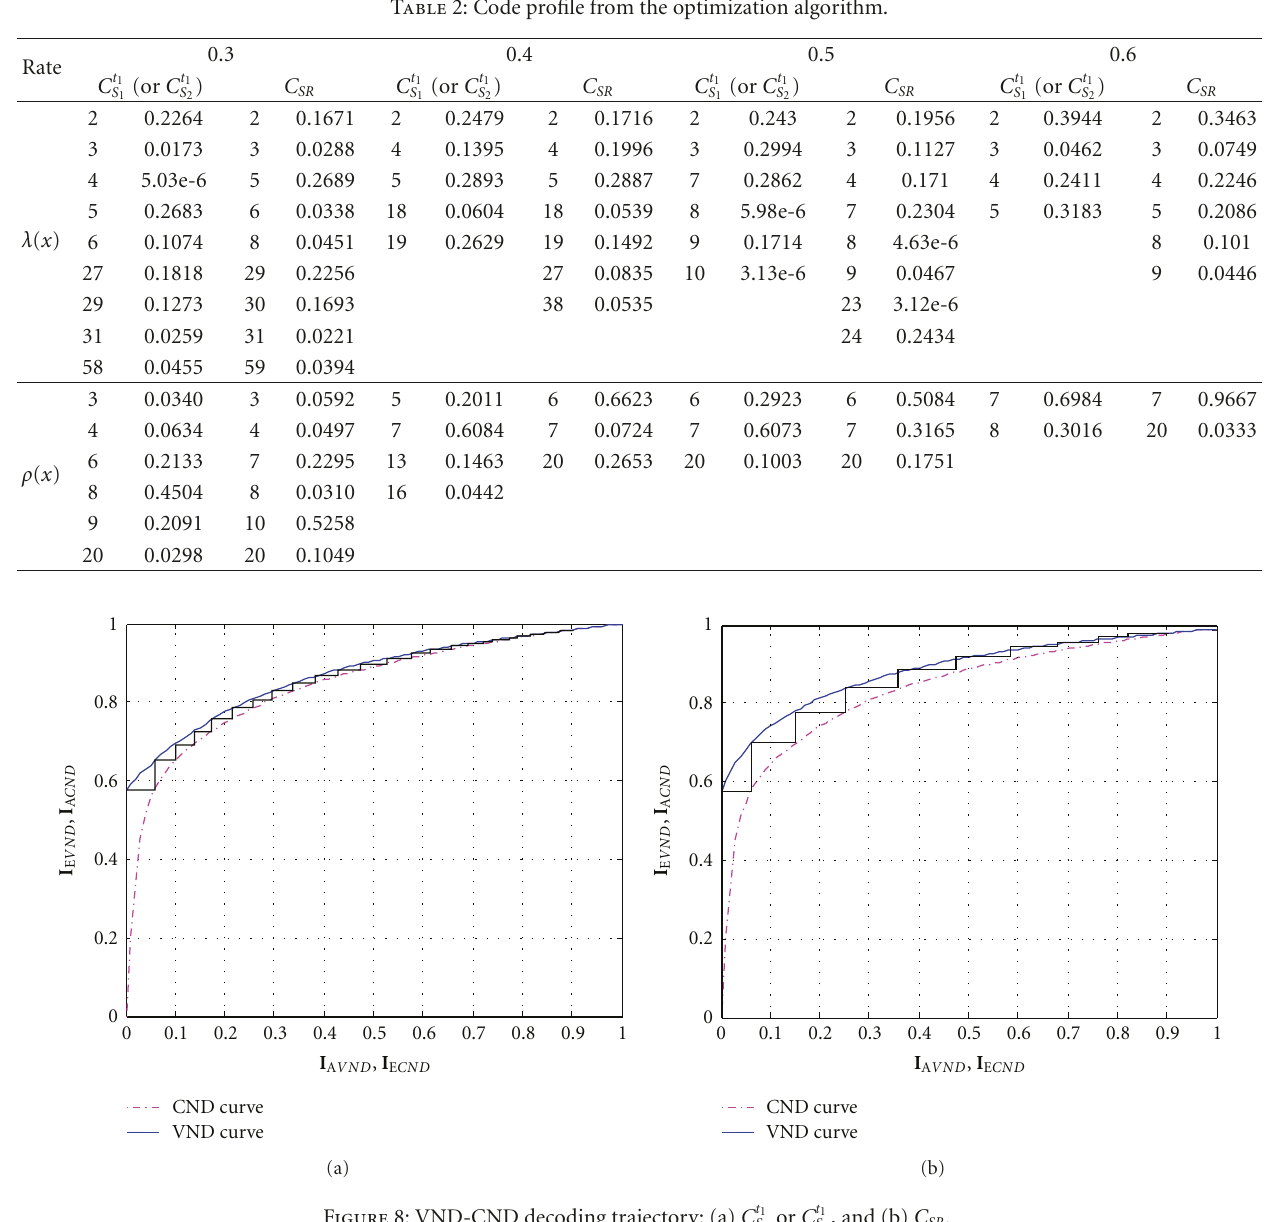
Figure 8: VND-CND decoding trajectory: (a) C t 1